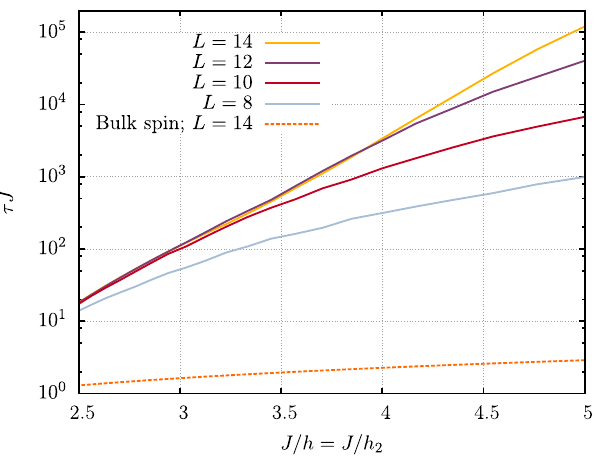
FIG. 2. The decay time (on a logarithmic scale) of a MZM at T ¼ ∞ for L ¼ 8 – 14 sites, as a function of h and h 2 , as obtained by exact diagonalization. The data collapse onto the form ln τ J ¼ J=h 2 f ð h=h 2 Þ þ constant, as expected, with deviations attributable to finite-size effects when the lifetime is long. The decay time of the spin at the center of the L ¼ 14 chain (dashed line) is not prethermalization protected and is much